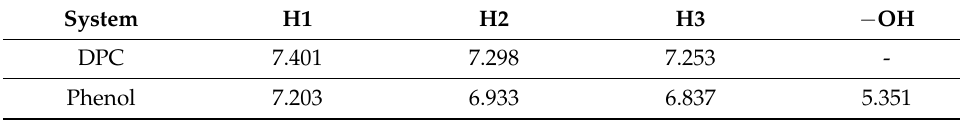
Table A2. Proton assignments and chemical shifts for DPC and